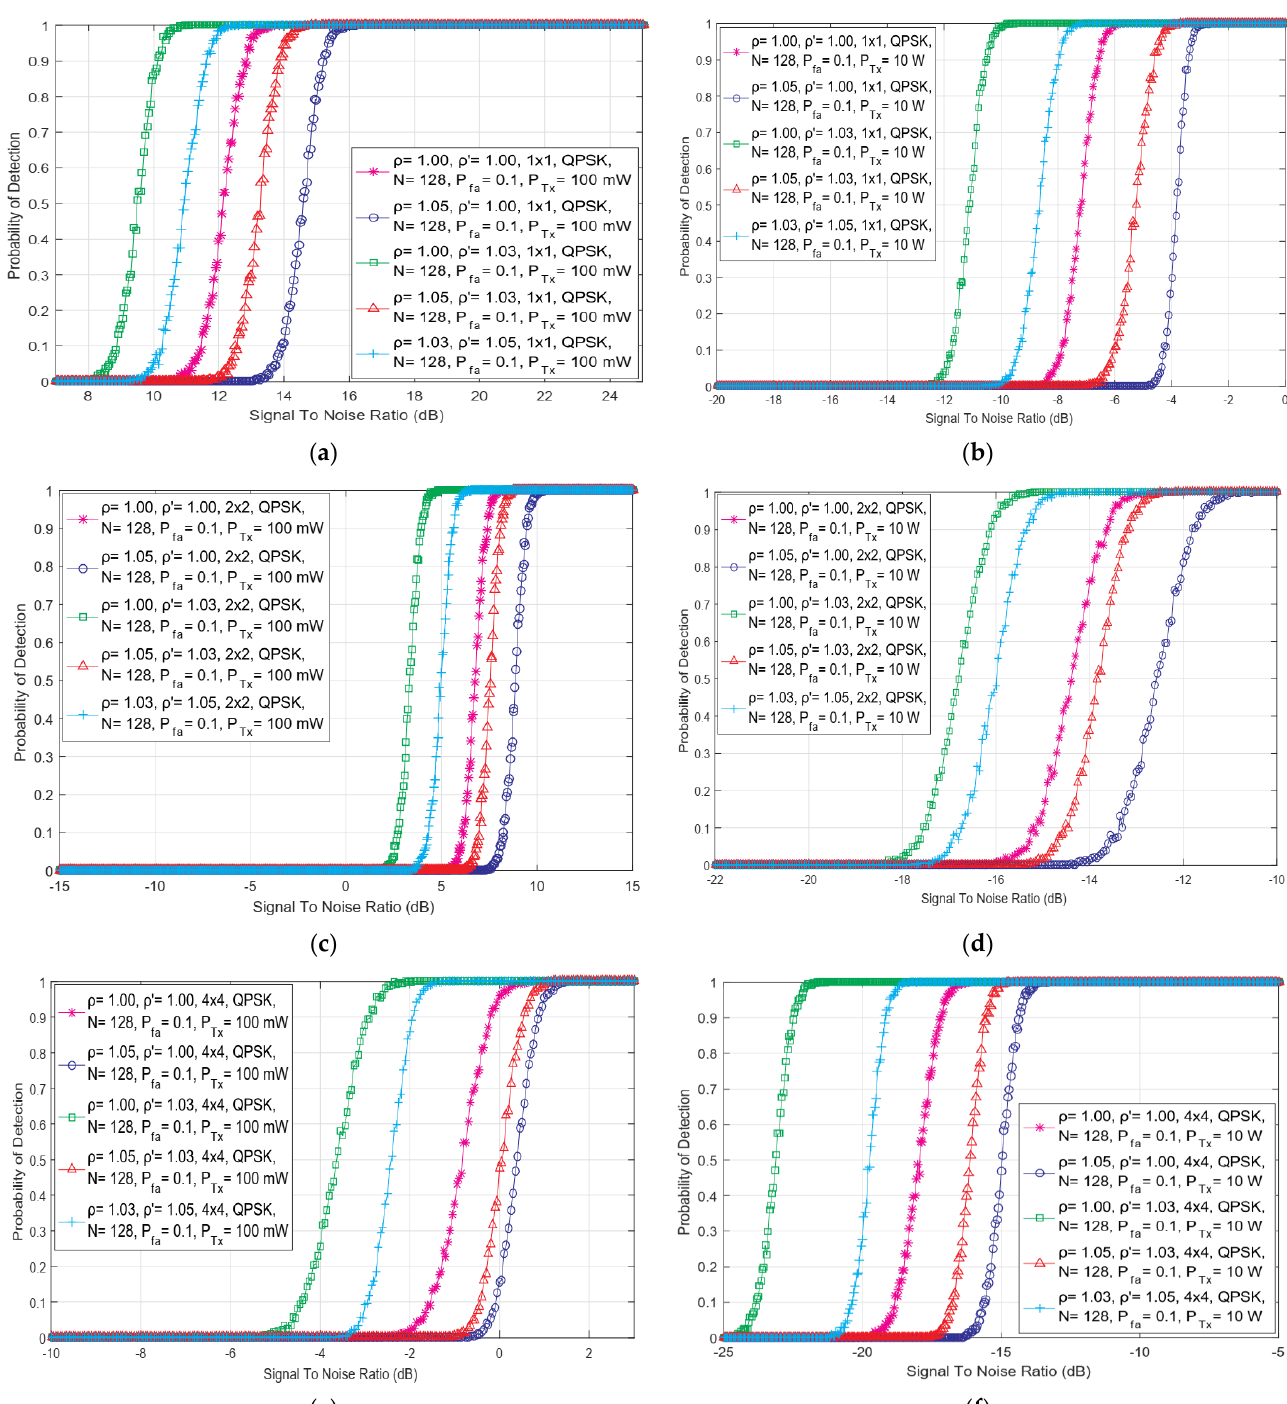
Figure 4. The dependency of detection probability on SNR of ED performed with different combi- nations of DDT and NU factors in communication: ( a ) SISO systems with 100 mW PU Tx power, ( b ) SISO systems with 10 W PU Tx power, ( c ) 2 × 2 MIMO systems with PU Tx power, ( d ) 2 × 2 MIMO systems with 10 W PU Tx power, ( e ) 4 × 4 MIMO systems with 100 mW PU Tx power and ( f ) 4 × 4 MIMO systems with 10 W PU Tx power.